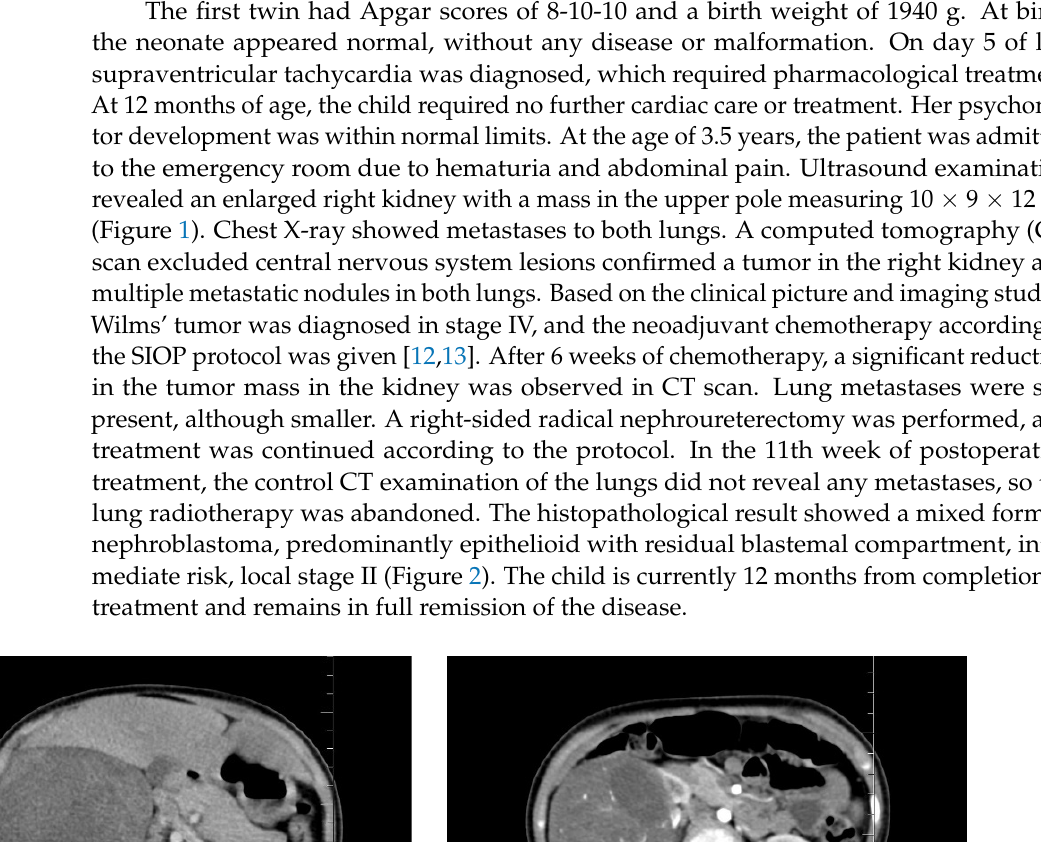
Figure 2. Wilms tumor mixed type with intermediate risk. Tumor specimen examination after 6- week preoperative chemotherapy. HE staining showed residual blastemic-epithelial compartment with regression areas. Immunohistochemistry with WT1 antibody showed residual blastemic nodules with epithelial elements; slides ( a – c )—the tumor tissue sections of the first sister; slides ( d – f )—the tumor tissue sections of the second sister. Slides ( b , c , f )—HE staining, magnification ×20. Slides ( a , d , e )—WT1 antibody (Origene) immunohistochemistry analysis in formalin-fixed and paraffin-embedded tumor tissue followed by peroxidase conjugation of the secondary antibody and DAB staining; magnification ×20 for slides ( a ) and ( d ) and ×40 for slide ( e ).